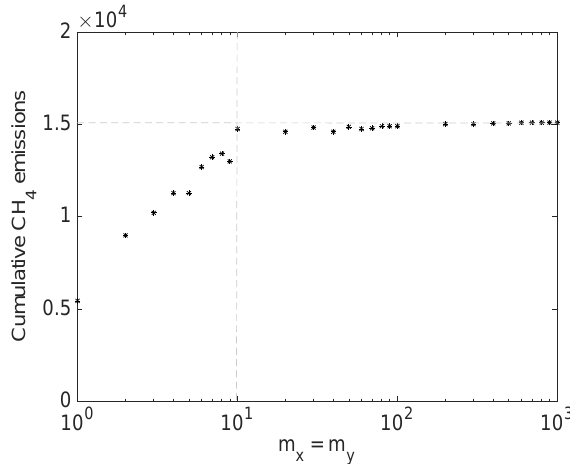
Figure 7. Dependence of the cumulative methane fluxes computed from the end of April to the end of October on the grid size of the micro-topographic model. The x axis shows the squared root of the √ N = m x = m y , where m x and m y are the number of cells N , as resolution horizontally and vertically, respectively. The x axis is on a logarithmic scale. Cumulative methane emissions greatly increase √ N ≤ 10, i.e., decreasing cell size from 1km 2 with increasing N if to 0.01km 2 in a 1km 2 domain. After this threshold, cumulative methane emissions stabilize as the number of grid cells increases. This phenomenon is mirrored by the average position of the water table dynamics (not shown), which by increasing N asymptotically approaches the water table dynamics for N = 10 6